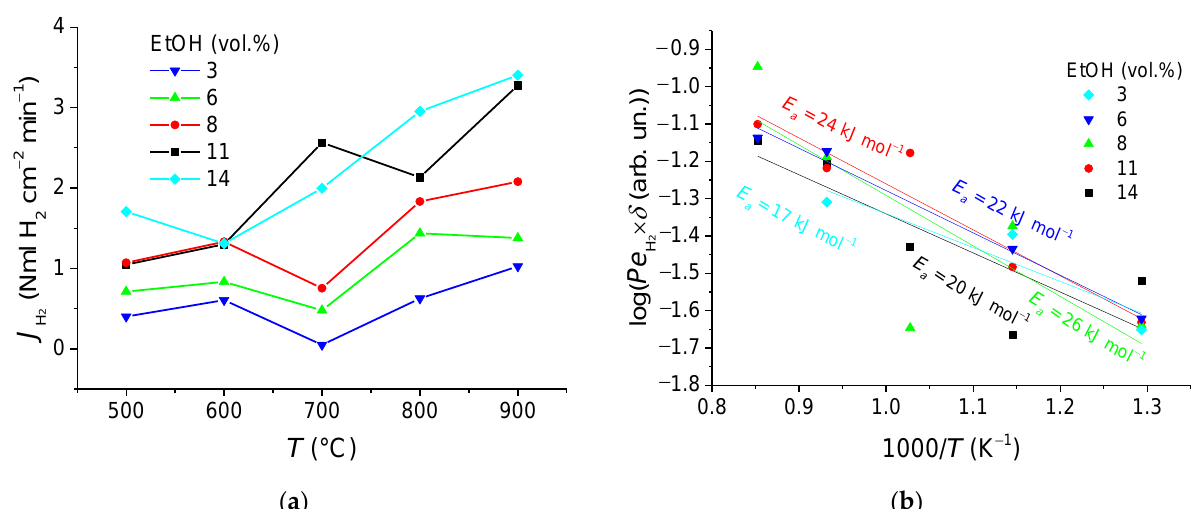
Figure 10. Hydrogen flux dependences on temperature ( a ) and corresponding Arrhenius plots ( b ) for S/E = 6 at the different fuel concentrations.